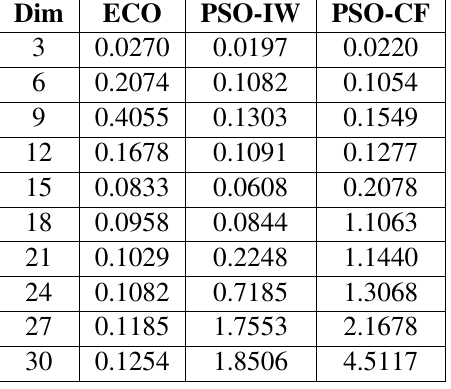
Table 7: Results on Griewank function from 3 dimensions to 30